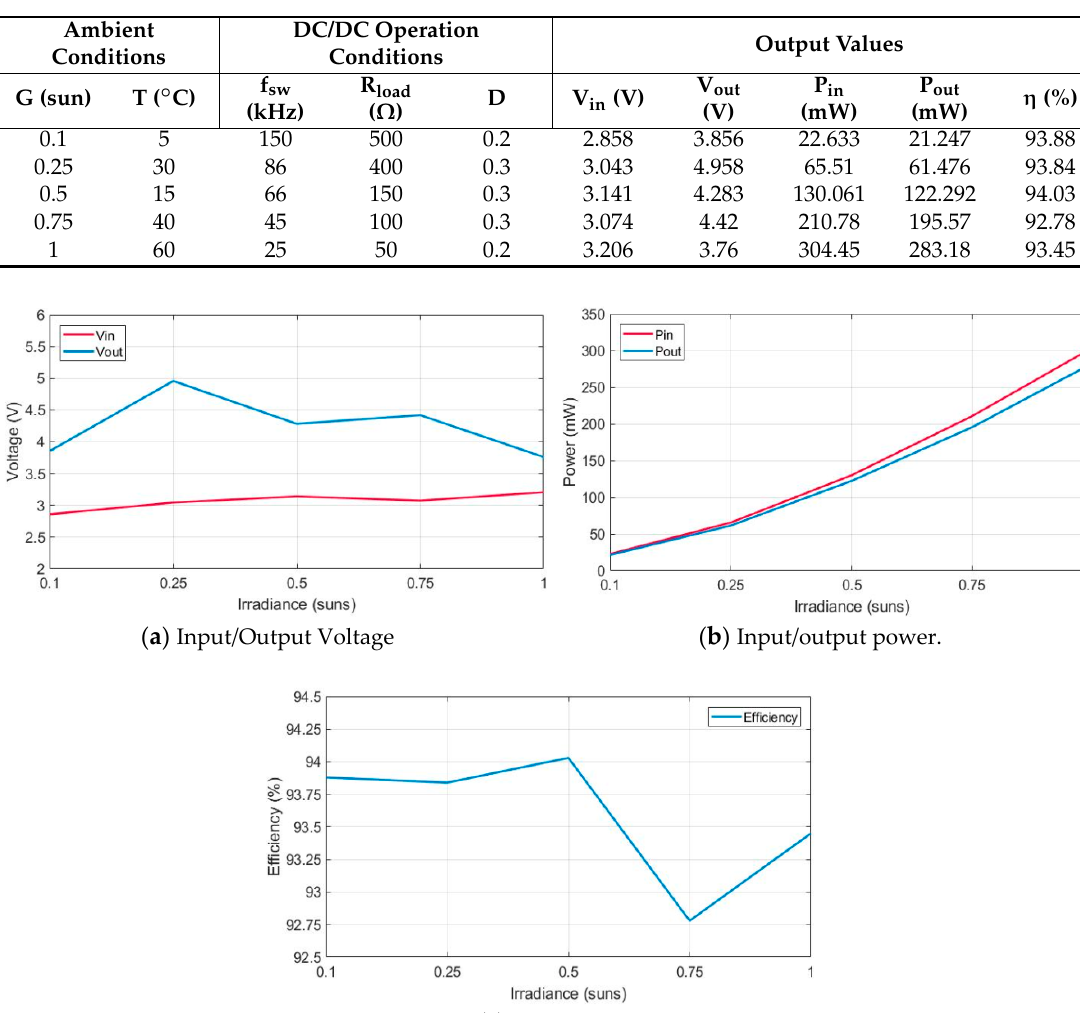
Table 10. Converter sweep maximum results with different irradiance and temperature.